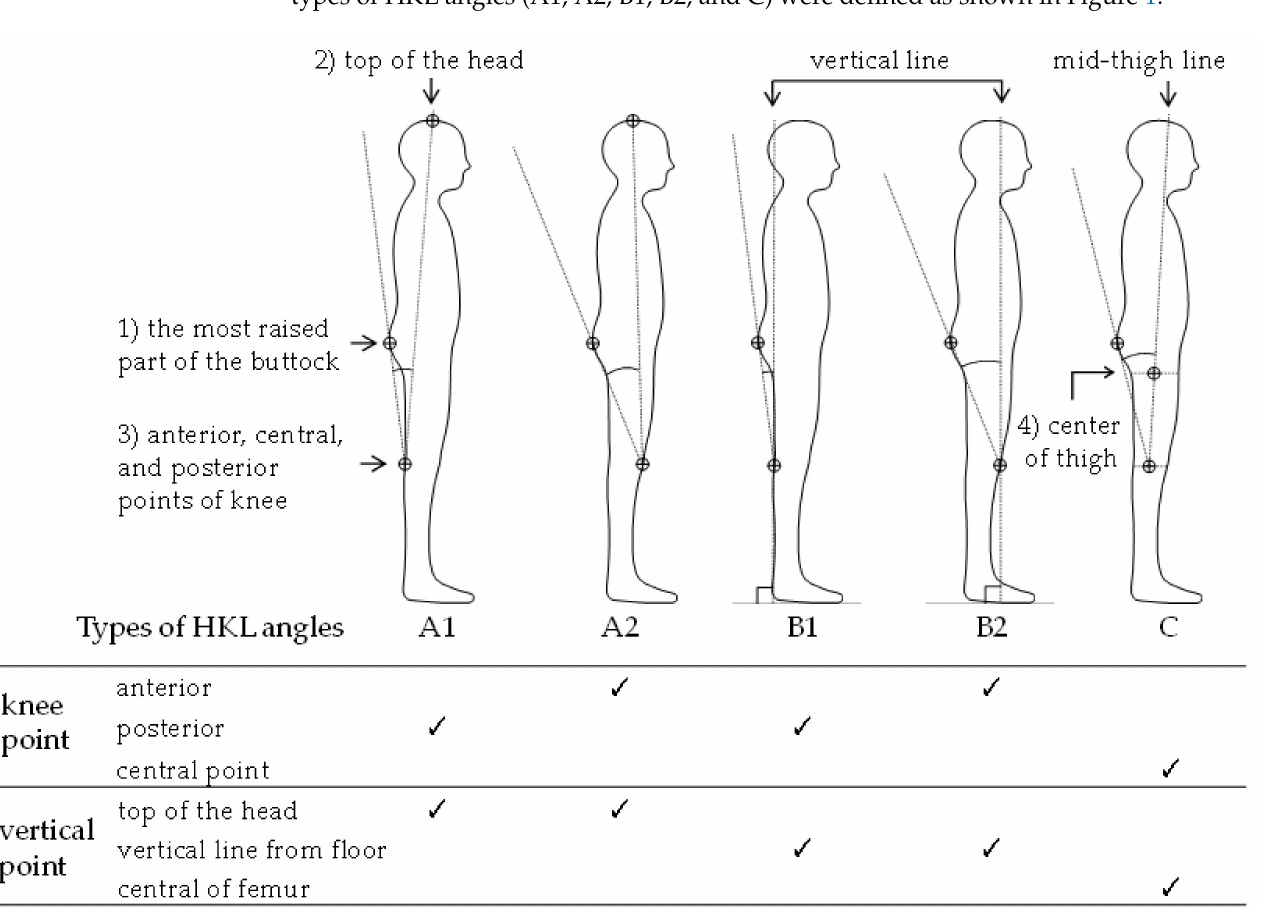
Figure 1. Five variation types of hip-knee line (HKL)